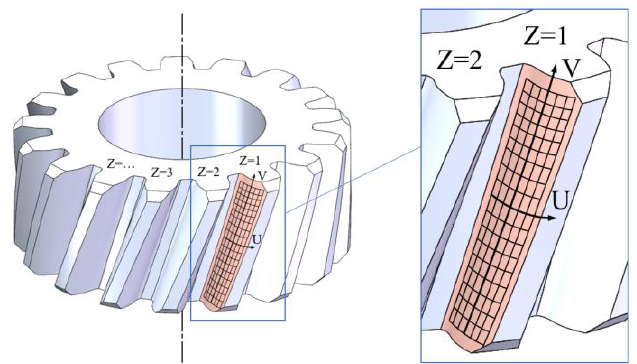
Figure 3. Specialized U-V-Z coordinate system.